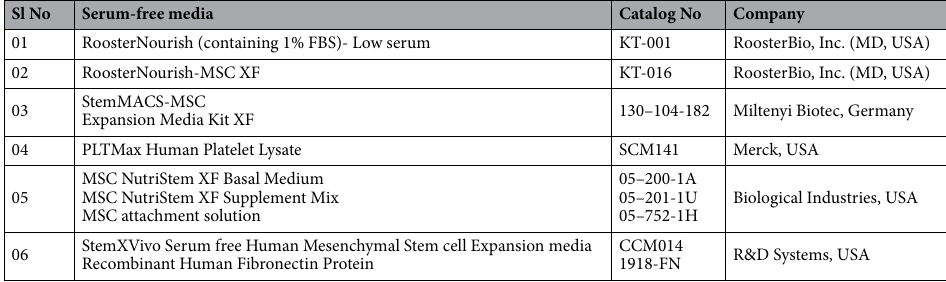
Table 1. List of commercially available low serum/serum-free/xeno-free media evaluated in the